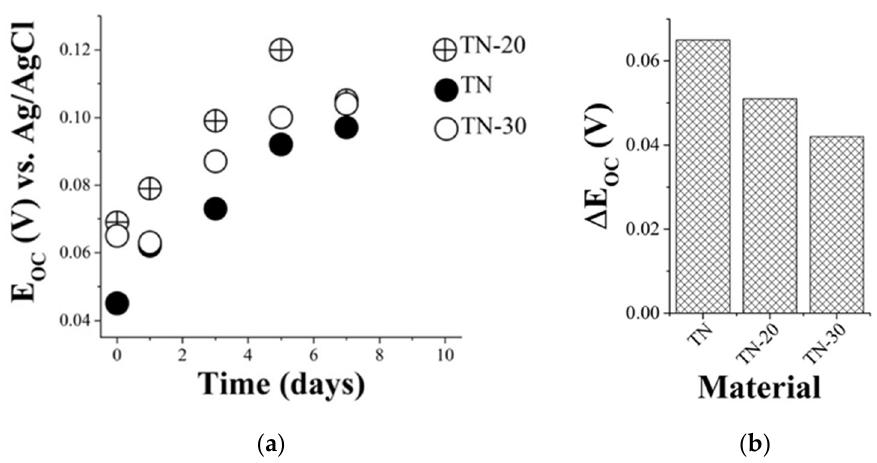
Figure 5. ( a ) Evolution over time of OCP values for samples stored in saline (inorganic fraction of DMEM) for 10 days. ( b ) The difference between initial and final OCP values observed for the samples after 10 days of immersion.